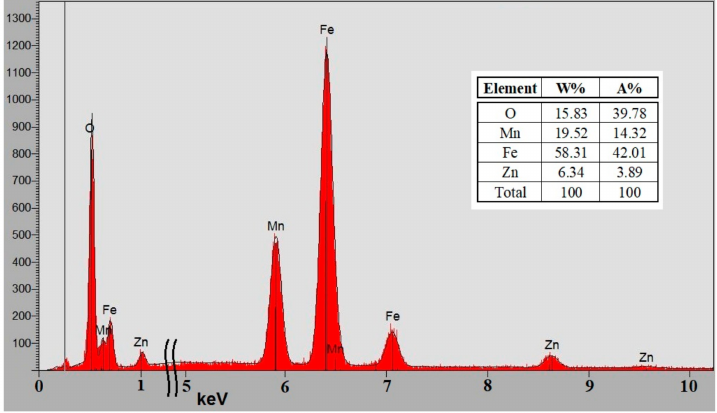
Figure 3. Energy-dispersive X-ray spectroscopy (EDS) of the MnZn ferrite revealing the chemical composition of the material.